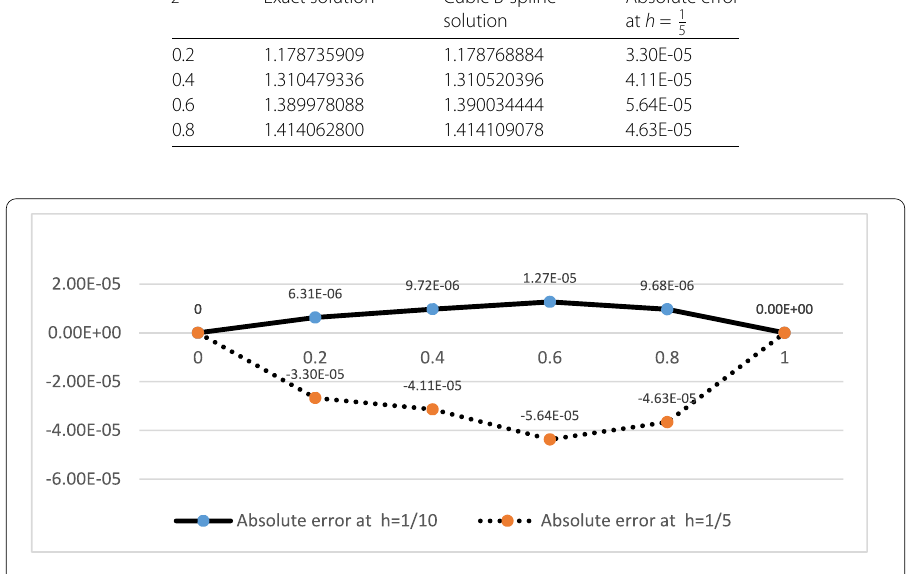
Figure 5 Comparison of exact and cubic-B solution for Problem